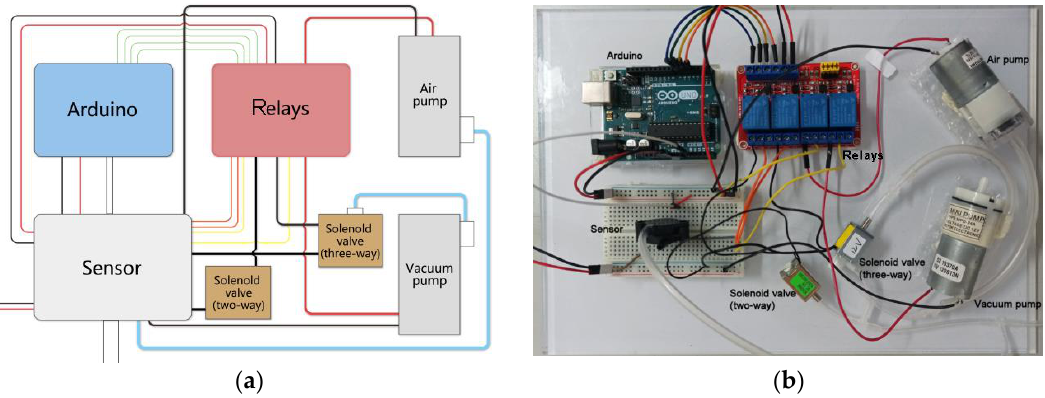
Figure 6. The control board. ( a ) The schematic diagram. ( b ) The prototype. The microcontroller Arduino could shift between output modes of either supply air, release air, extract vacuum, or stay loop close. According to Figure 7, the control messages were compared with real-time states to decide the power mode. The control messages were transformed into the corresponding preset pressure that was able to assist in specific hand motion. The current pressure was monitored upon an air sensor. If the value of PP were close to that of CP, the system would delay and wait for the next control message; or the control system would keep adjusting until meeting the condition. When PP-CP is less than an acceptable value of error x. When x is infinitely close to 0, CP is much closer to PP. However, in this experiment, taking into account the performance of air pump, we set x as 1 KPa for RE, and we set x as 5 KPa for SF and RS. Figure 7. Control strategy.